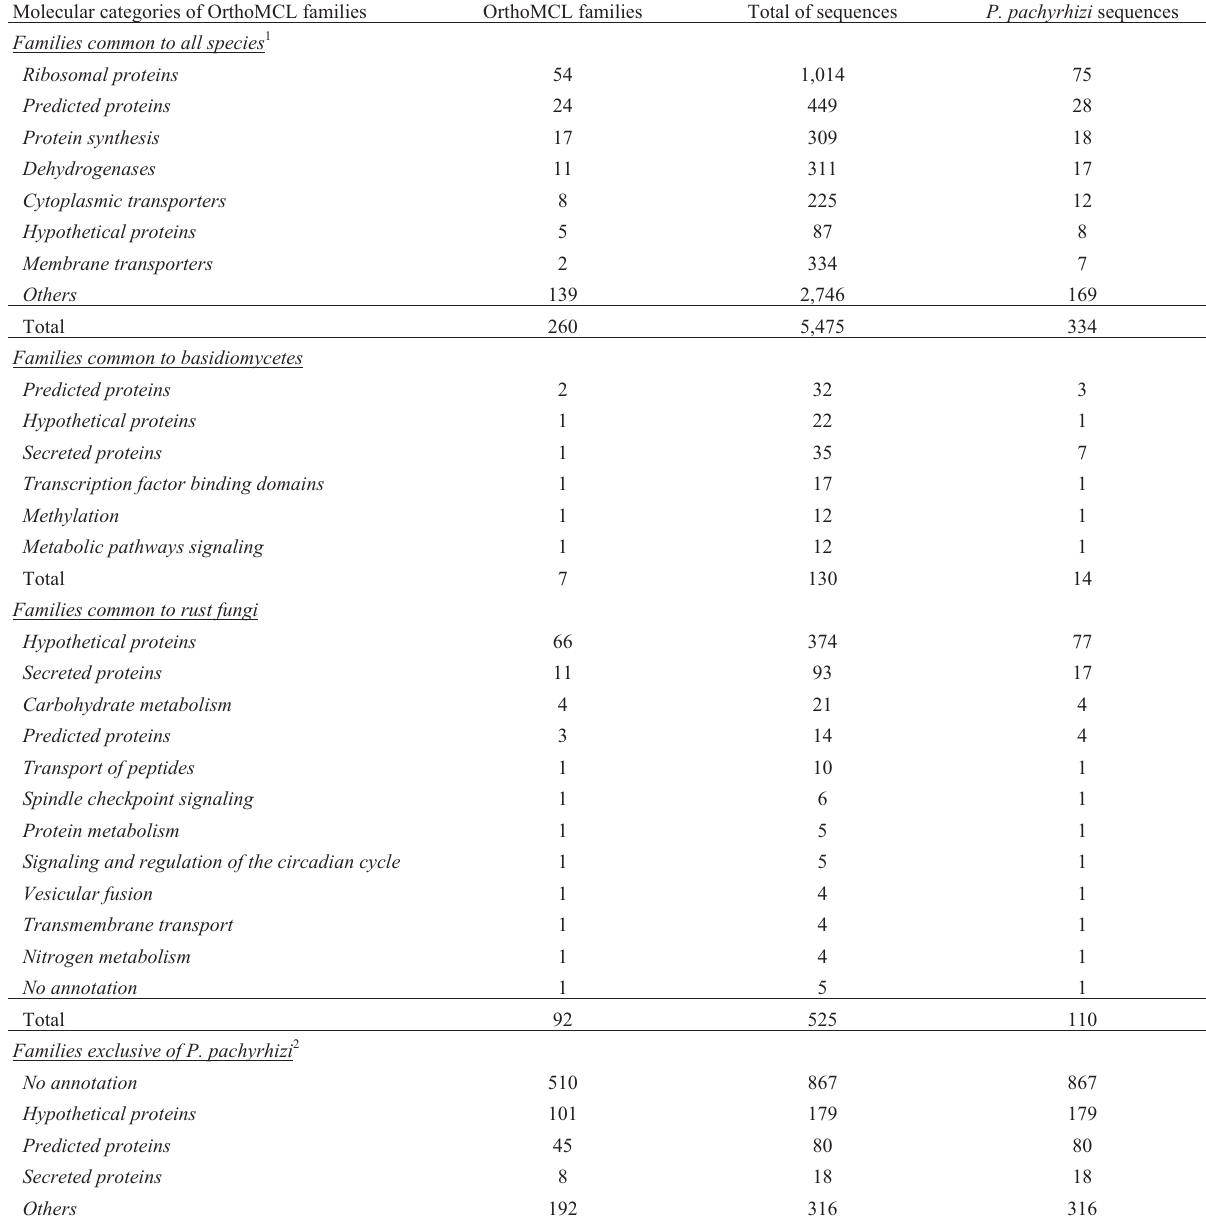
Table 3 - General characteristics of the comparative analysis between the OrthoMCL multigene families obtained from the predicted proteins of the P. pachyrhizi transcriptome and proteins predicted from other 15